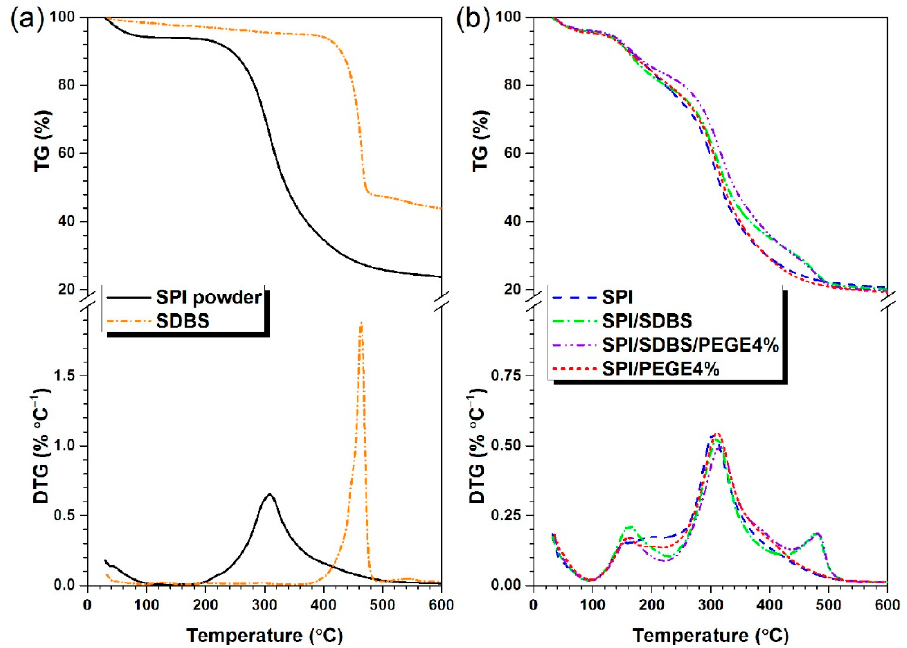
Figure 4. TG and DTG curves of the feedstocks, i.e., SPI powder and SDBS ( a ); and fabricated films, i.e., SPI, SPI/SDBS, SPI/SDBS/PEGE4%, and SPI/PEGE4% ( b ). Table 2. TG parameters for the thermal degradation of SPI powder, SDBS, and SPI-based films.